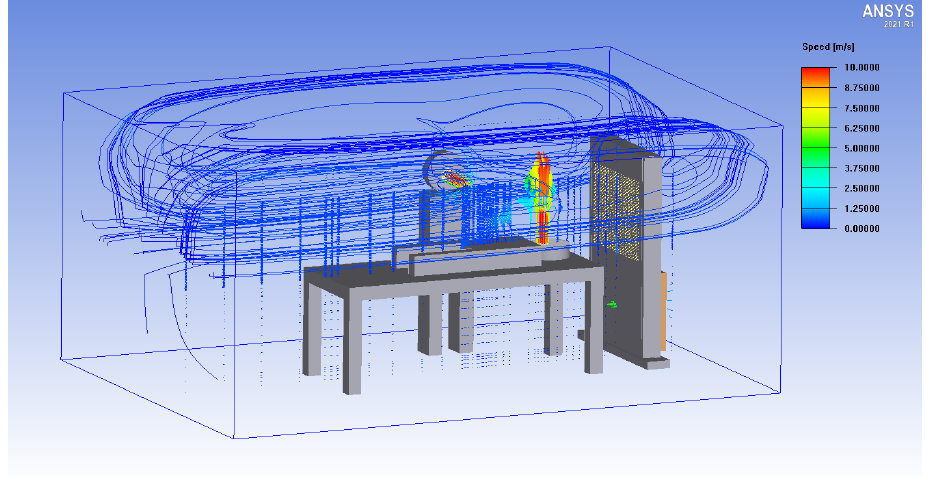
Processes 2022 , 10 , x FOR PEER REVIEW Figure 24. Air purifier simulation in the hospital ward at a high rotation speed.